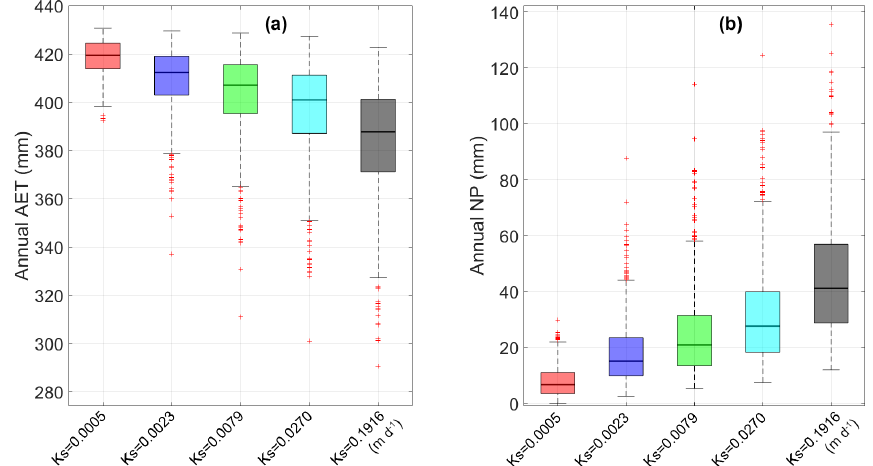
Figure 13. Box plots showing the distribution in variability in the simulated water balance components of (a) AET and (b) NP with variation in the soil hydraulic parameters, for instance, K s of the LOS overburden. Variability of each water balance component is represented for the five illustrative covers. The description of the box plots is the same as for Fig.